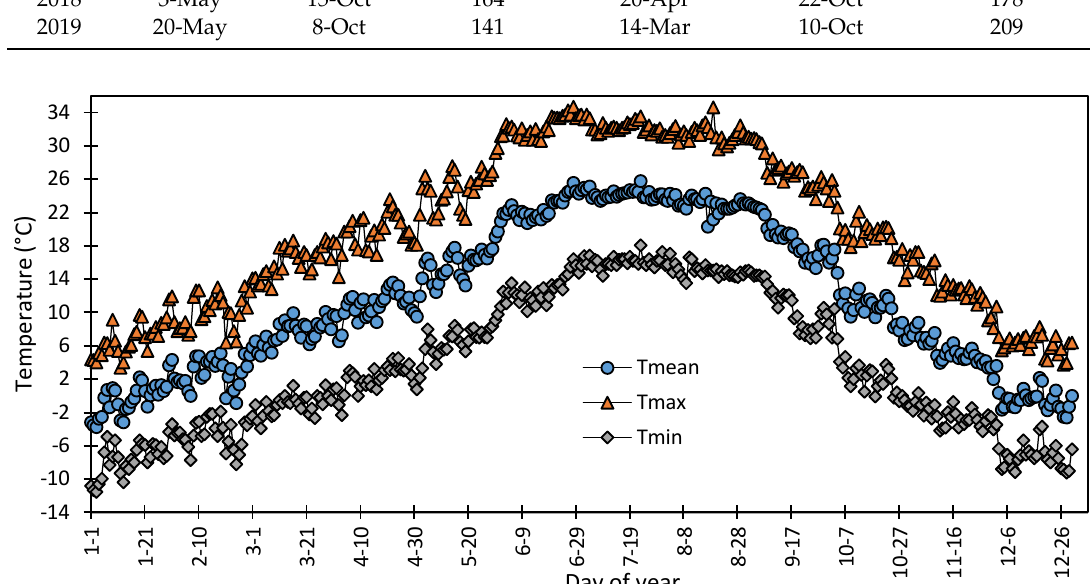
Figure 2. Trend in the daily average relative humidity and solar radiation for 2003 – 2019 period at the Agricultural Science Center at Farmington, New Mexico. 2.2. Crop Management Selected numbers of hybrid maize grouped according to their relative maturity date as early season and full season were tested each year; however, only early season hybrids were evaluated during the 2012, 2013 and 2014 growing seasons. Out of a total 407 maize hybrids evaluated, 343 hybrids had relative maturity comprise between 93 and 119 days (Figure 3) and 64 hybrids had unknown relative maturity.